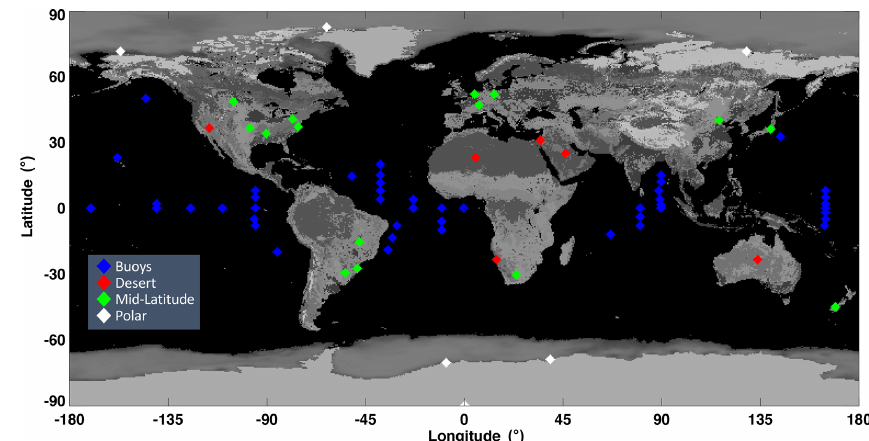
Figure 11. The location of surface observations of downwelling shortwave irradiance used to compare the SYN1deg Edition 4.1 calculations to observations for all available hours (from March 2000 through December 2019) for which the SYN1deg cloud analysis determines the hour and grid box to be 100% clear sky.